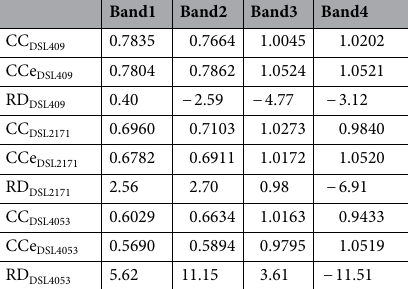
Table 4. Comparison of cross-calibration coefficients. Coefficients Unit: W/(m 2 sr